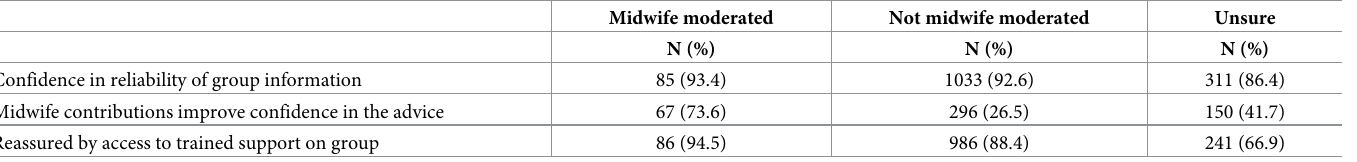
Table 3. Moderator related BSF group experiences by group type.